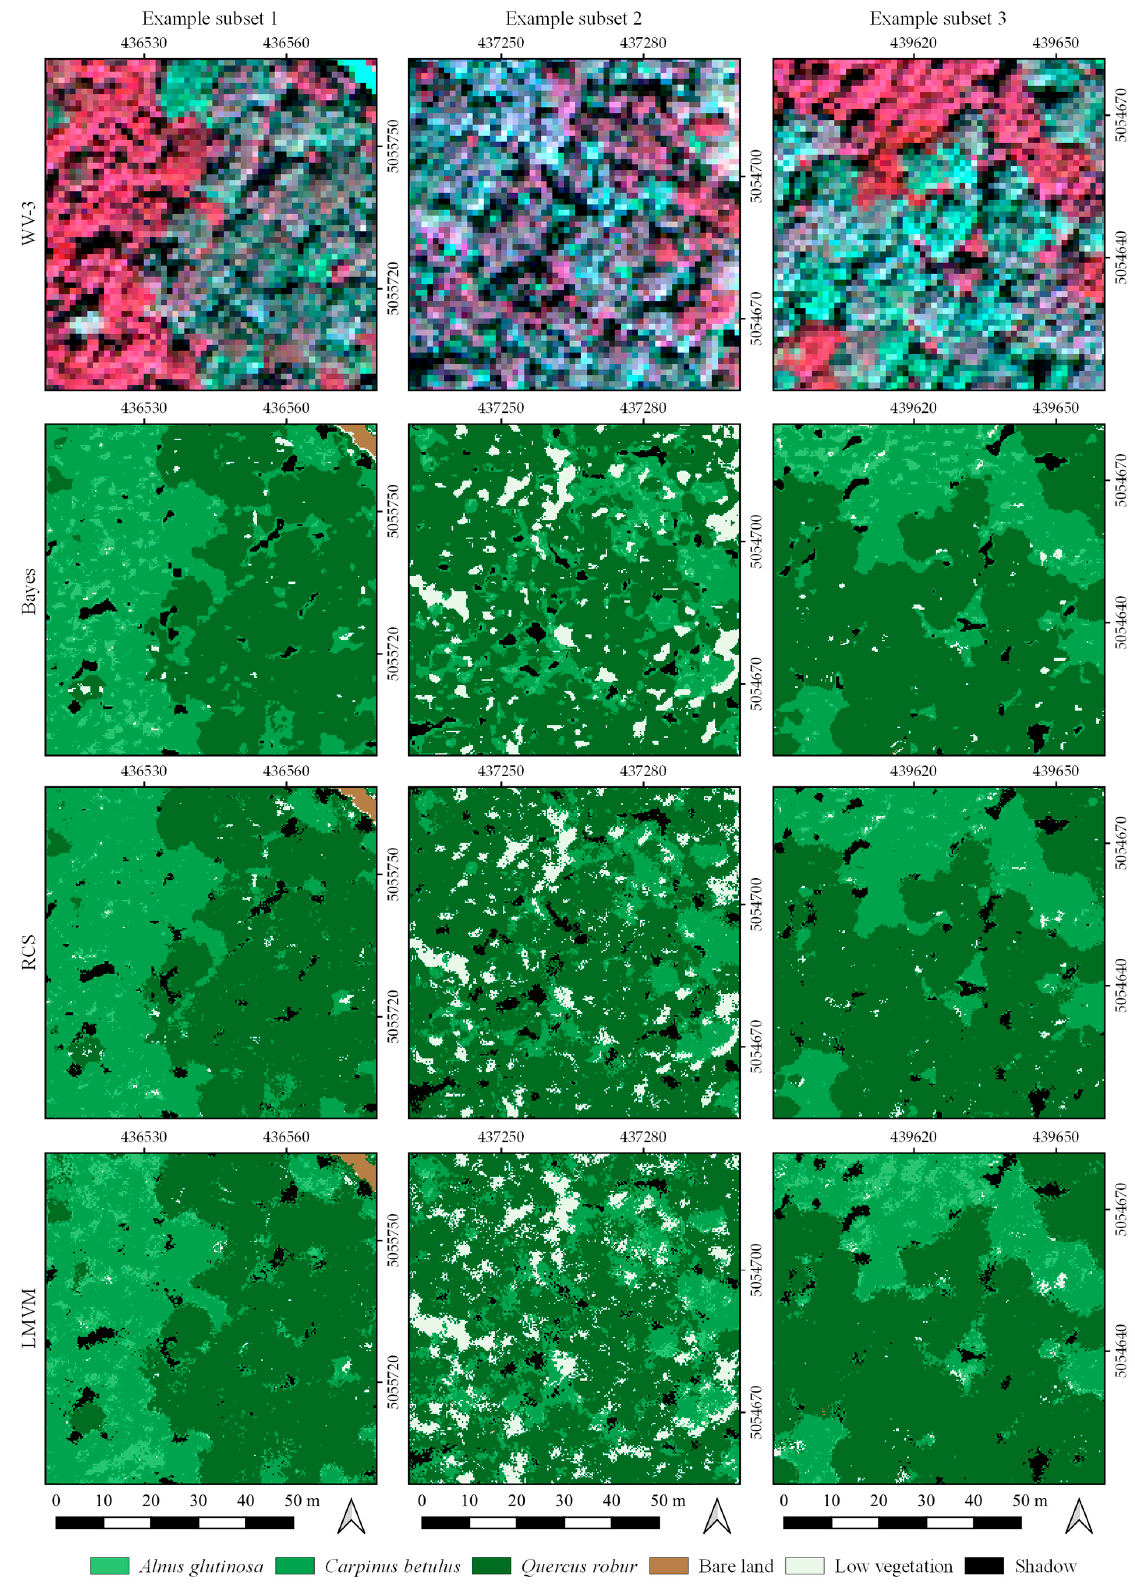
Figure 3. Three example subsets: ( 1st row ) false-color composite of WV-3; ( 2nd row ) pixel-based classification using Bayes pansharpened imagery; ( 3rd row ) pixel-based classification using RCS pansharpened imagery; ( 4th row ) pixel-based classification using LMVM pansharpened imagery.